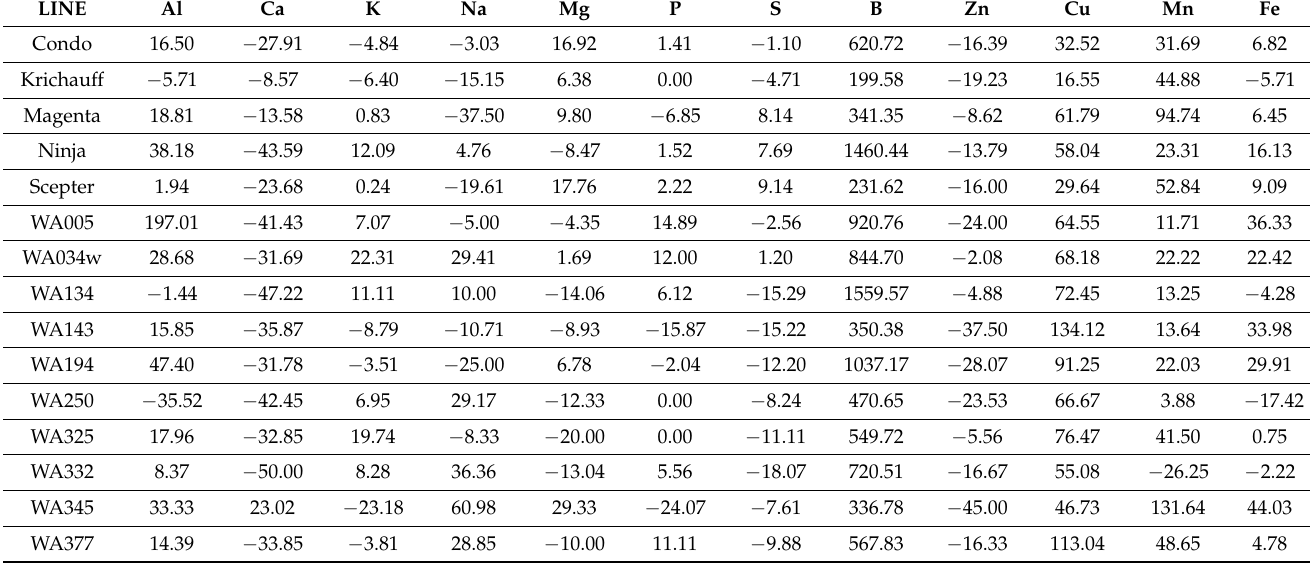
Table 4. Changes of the leaf mineral accumulation (%) from non-sodic to sodic